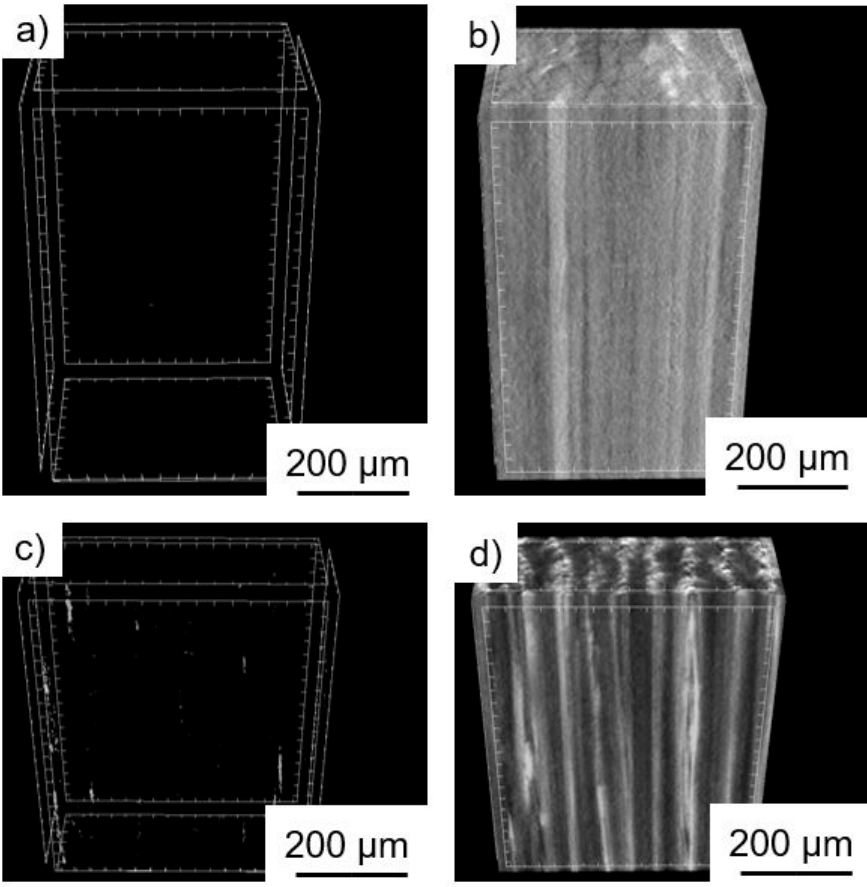
Figure 5. Micro-CT scans from the nickel-coated sample with 55.2 vol % fiber ( a , b ) and copper-coated sample with 39.5 vol % fiber ( c , d ). The images in ( a ) and ( c ) show the voids of the laminates.